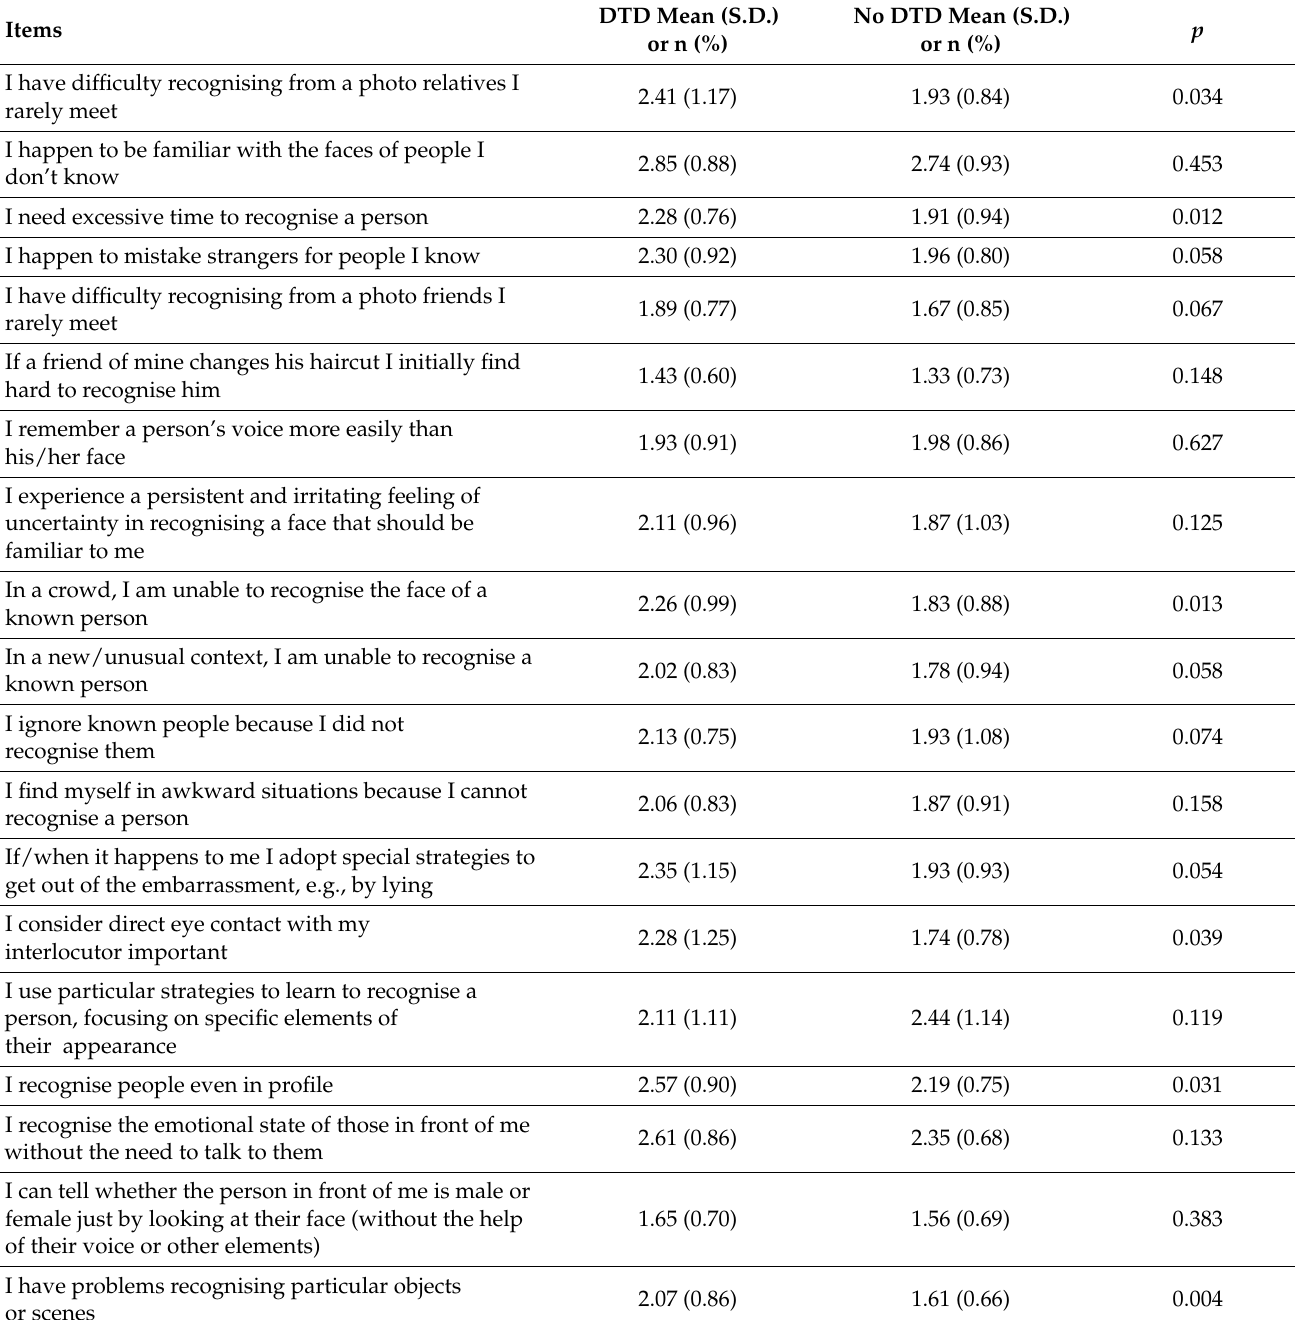
Table 3. Means and S.D. of each item which investigated the difficulty to recognize faces and